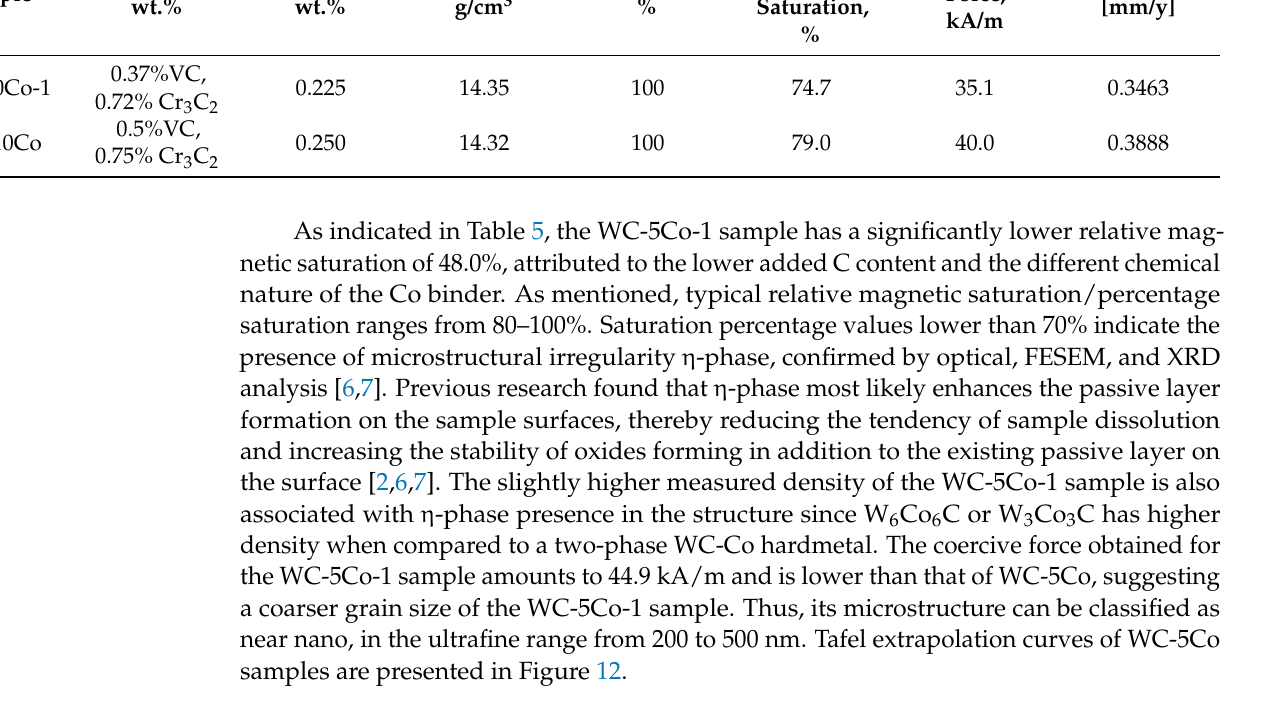
Table 6. Comparison of WC-10Co samples with different microstructural characteristics and magnetic saturation. Table 5. Comparison of WC-5Co samples with different characteristics.